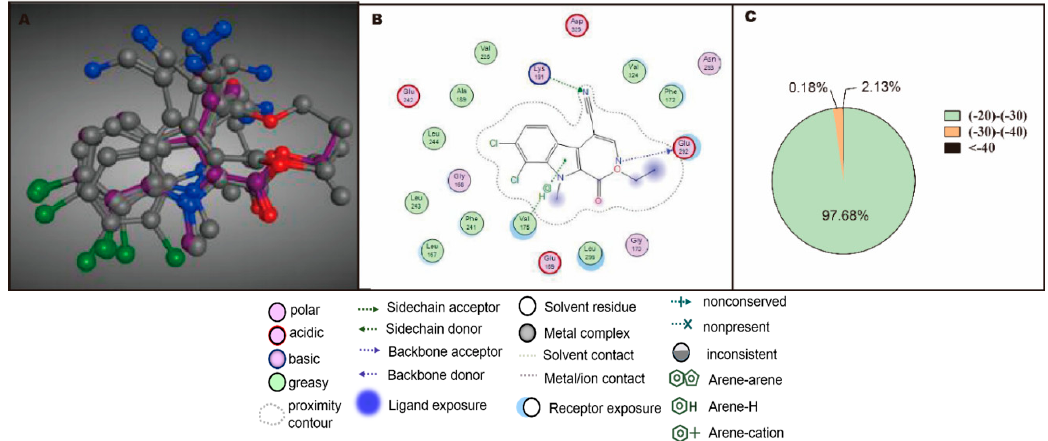
Figure 5. Virtual screening of lead compounds with CLK1 inhibitory effect. ( A ) Top five poses docking of ligand V25 in binding pocket of 2VAG, with RMSD value of 1.38 Å; ( B ) The interaction between ligand V25 and receptor is crucial for binding; ( C ) The proportion of different levels of scores according to virtual screening.